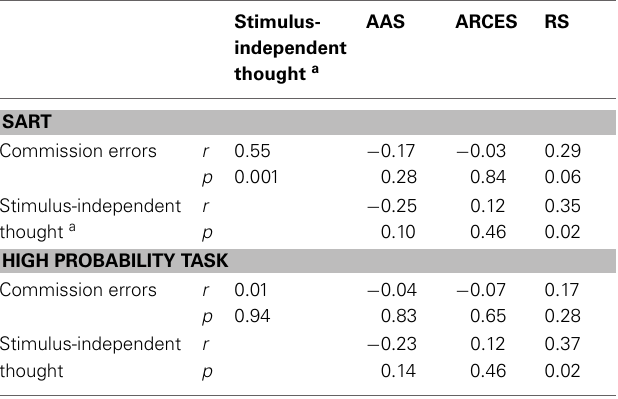
Table 5 | Correlations between behavioral performance, self-reported stimulus-independent thought and other participant characteristics ( n =